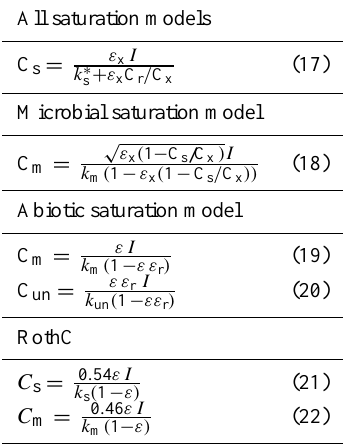
Table 3. Analytical solutions to the steady-state level of the SOC pools in each model. Carbon input rate ( I) and turnover rates k s , k m , and k un must have same time units.